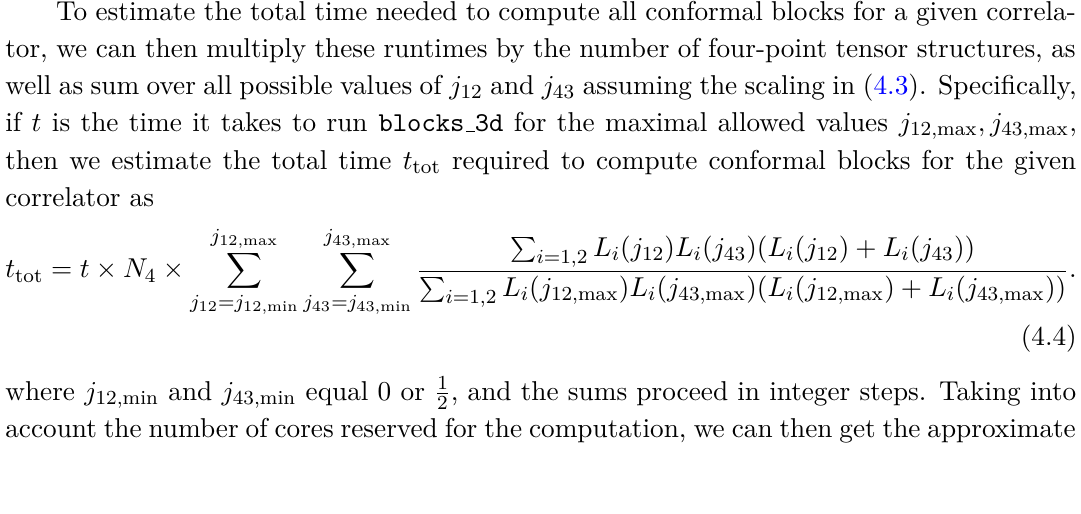
and for a single choice of four-point structure, given , j 12 43